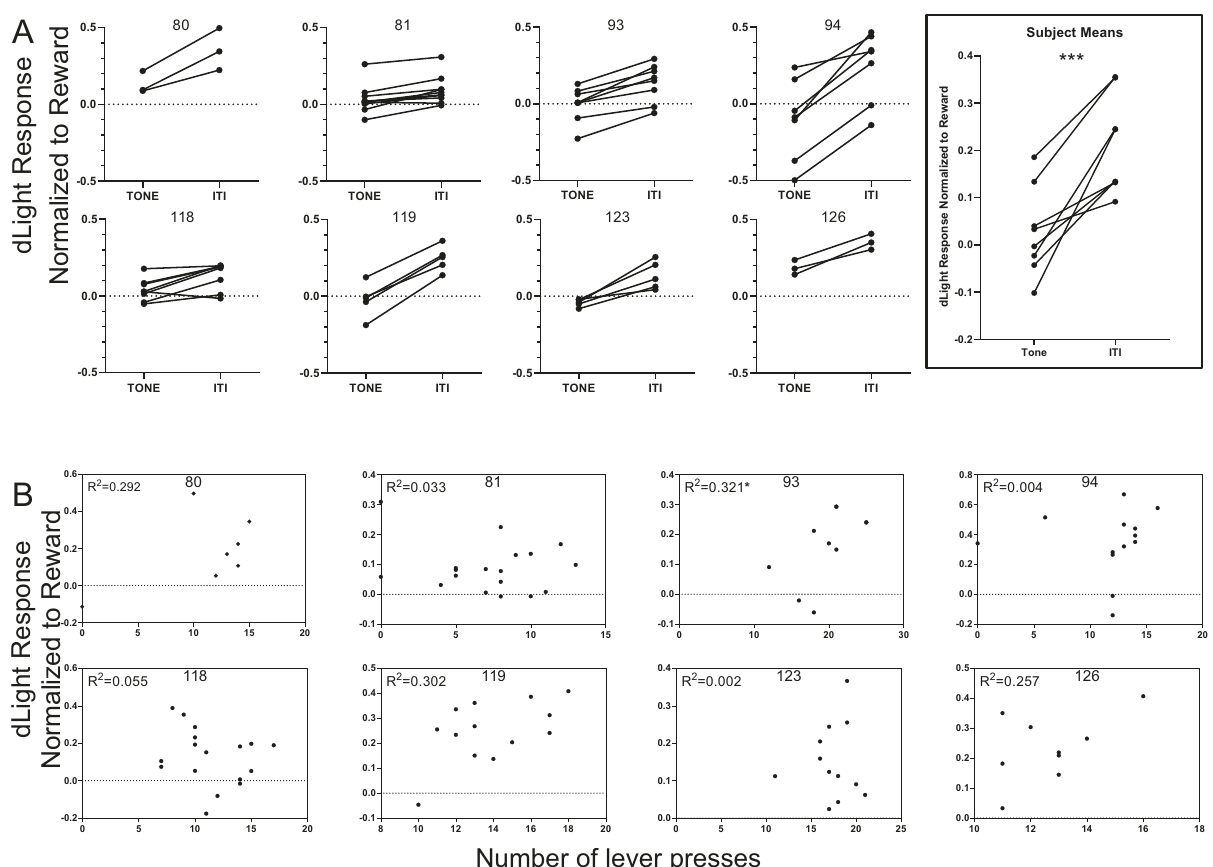
Fig. 4 Dopamine encodes reward availability state independent of reward and activity. A dLight responses in the last 10s of S − tone presentations are consistently lower than dLight response in a 10s period without rewards in the following ITI. Each single subject plot includes the 3 – 10 trials in which no reward was earned in the fi rst 20s of the ITI during the last session with dLight recording (session 20). The right most plot depicts the mean S − tone and ITI dLight values for each subject. Paired 2-tailed t test: t (7) = 5.546, p = 0.0009. B Each single subject XY plot depicts the dLight response and the number of lever presses made in the same 10s ITI period depicted in 4a for the last 2 sessions with dLight recordings (sessions 18 or 19 and 20, all post-acquisition). Pearson correlation coef fi cient, (two tailed) identi fi ed a relationship between dLight and lever presses for only one subject, 93: number of pairs:16, r = 0.5665, R squared = 0.3209, p = 0.0221. N = 8 animals. * p < 0.05; *** p < 0.001. Source data for ( A , B ) are provided as a Source Data fi